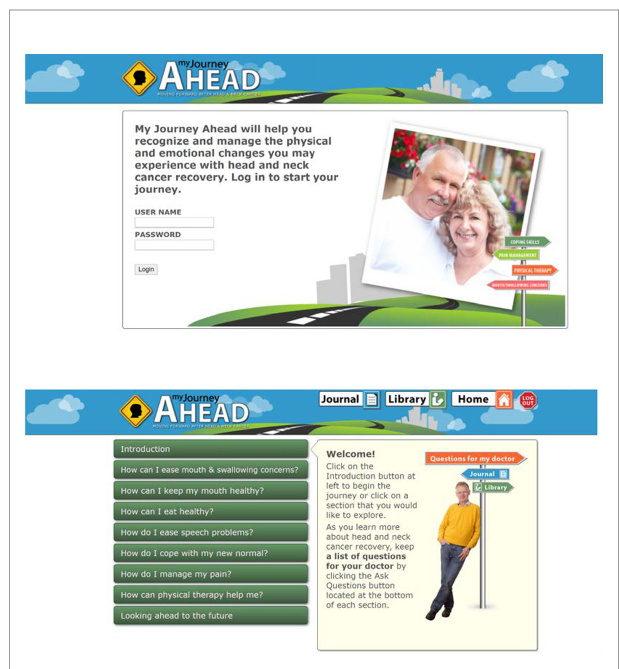
FIGURE 1 | My Journey Ahead Login Screen and List of Units. Note: Images used in these screenshots were obtained from a public